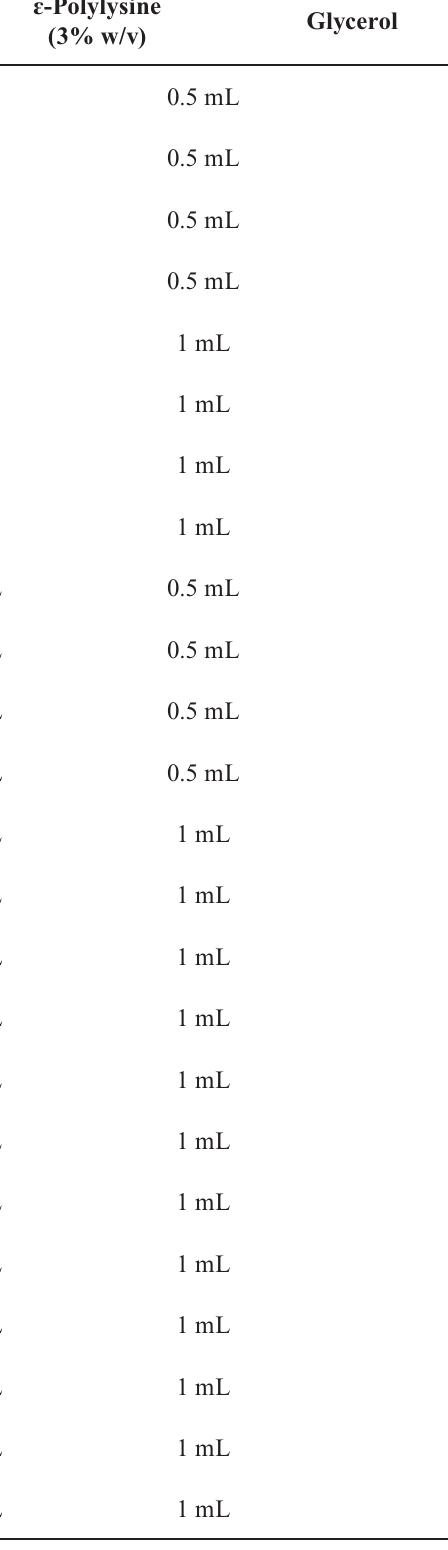
TABLE II – Three 2 3 factorial designs to films using chitosan, glycerol, PVA and/or ɛ -Polylysine